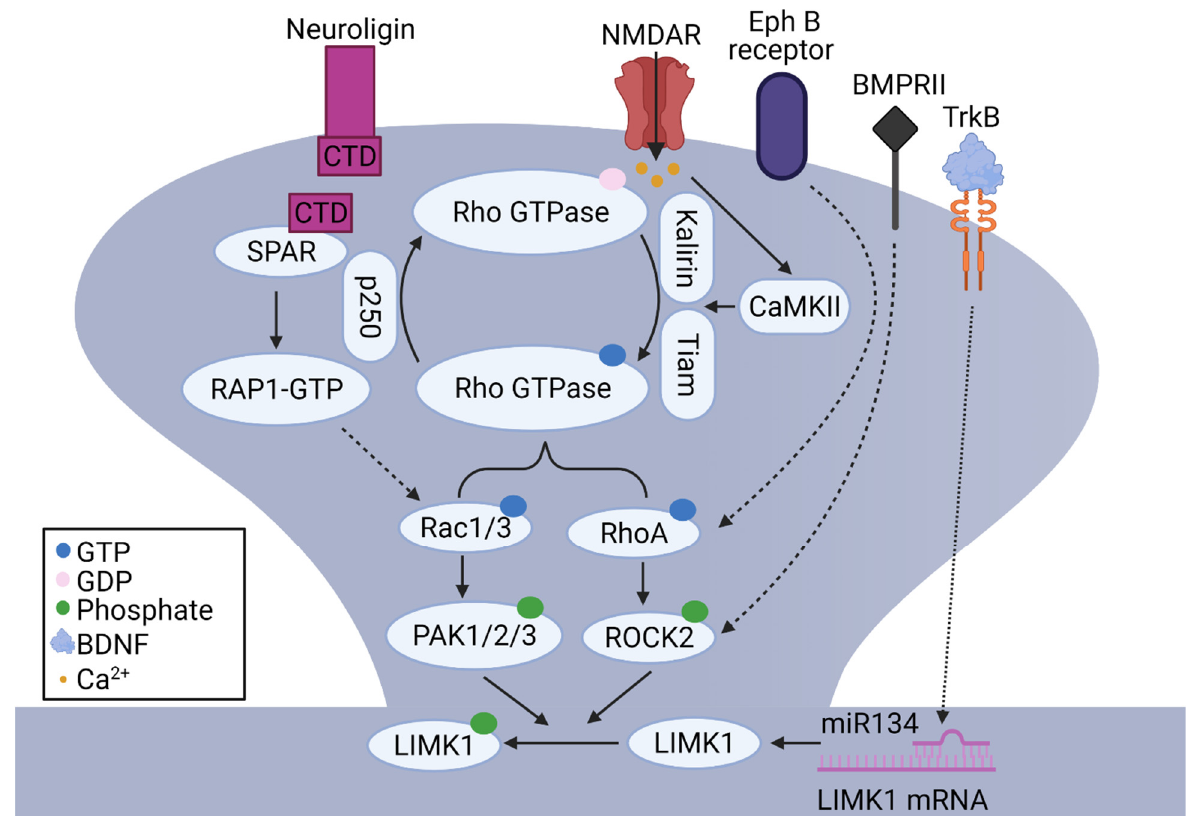
Figure 2. Signaling pathways regulating LIMK1 activity at the synapse. The activation of NMDARs causes Ca 2+ influx into dendritic spines. The increased intracellular Ca 2+ activates CaMKII, which in turn activates Rac1/3 through Kalirin and Tiam or RhoA through p250. These Rho GTPases bind to and activate PAK1/2/3 and ROCK2, which subsequently phosphorylate and activate LIMK1. LIMK1 can also be activated following NLG1 activation through the SPAR/RAP1/Rac1 pathway. Ephrin receptors can also activate LIMK1 through the RhoA/ROCK2 pathway. In addition, BMPRII receptors can interact with and activate LIMK1. The binding of BDNF to TrkB receptors relieves miR134-mdicated repression of LIMK1 mRNA and induces local translation of LIMK1 within dendrites.